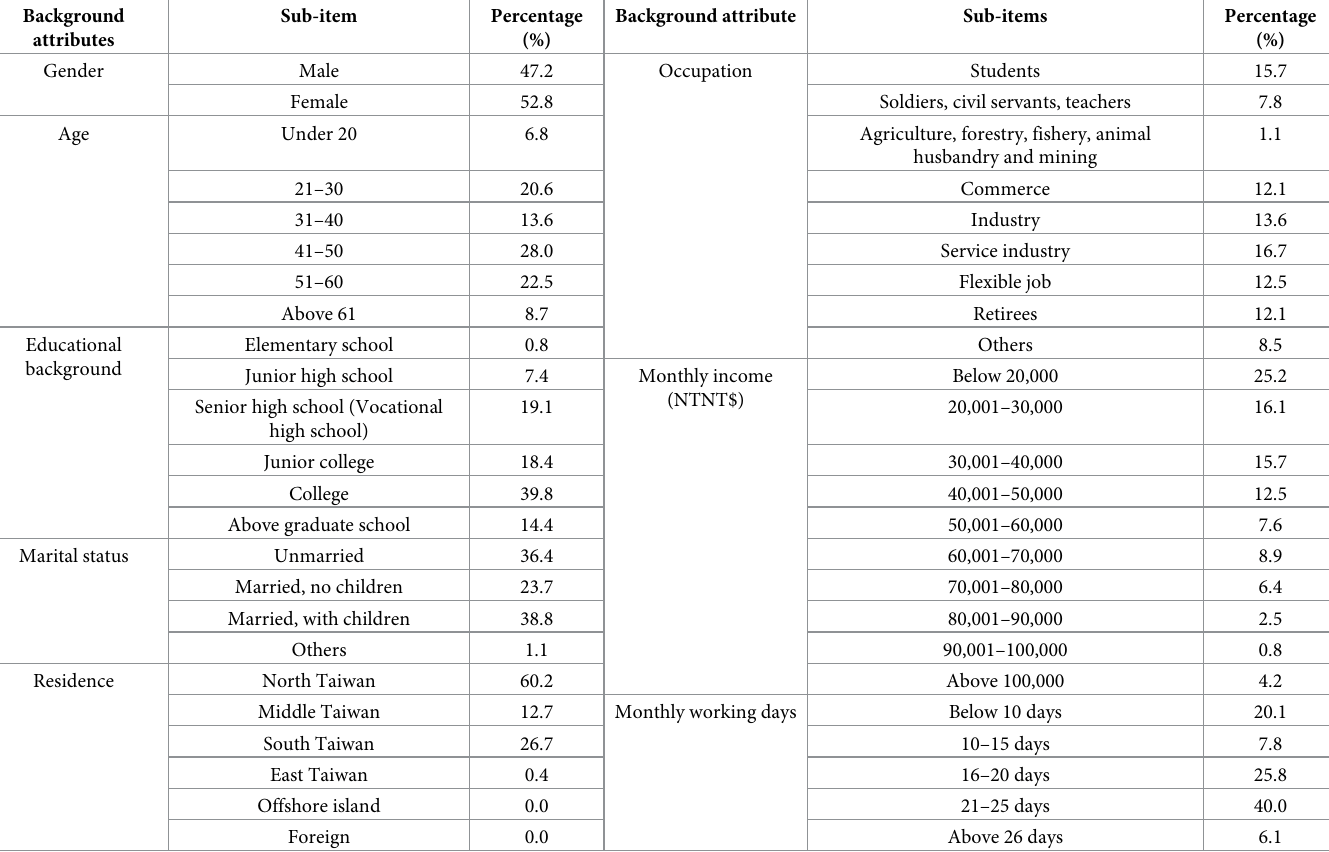
Table 1. Background attribute frequency allocation table of tourists visiting the Guanwu National Forest Recreation Area in Taiwan. Background